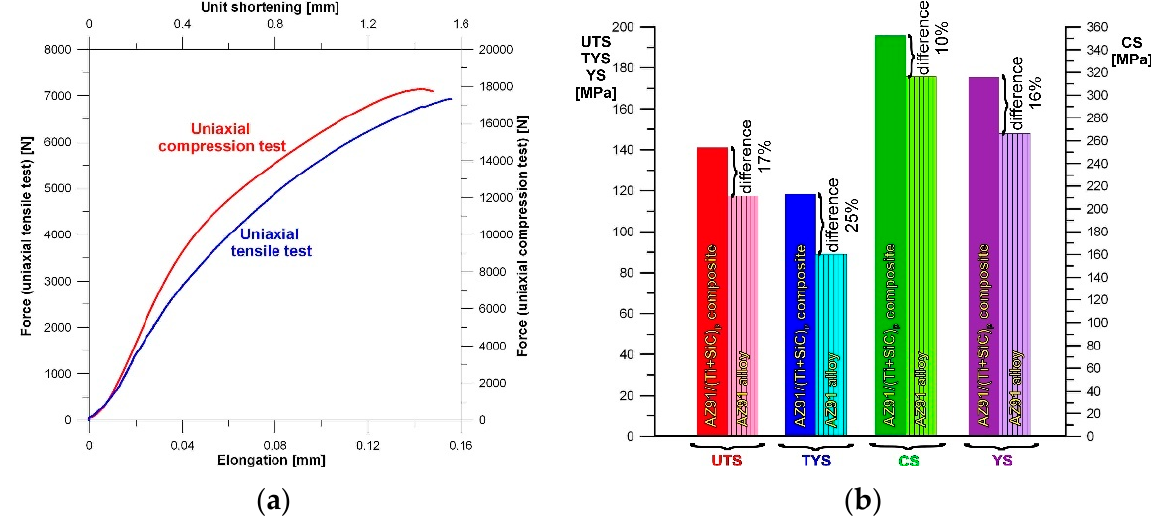
Figure 9. ( a ) Representative tension and compression curves for AZ91/(SiC + Ti) p hybrid composite; ( b ) Ultimate tensile strength (UTS), yield strength (TYS), compression strength (CS) and yield strength under compression (YS) of AZ91/(SiC + Ti) p hybrid composite compared with unreinforced AZ91 matrix alloy.